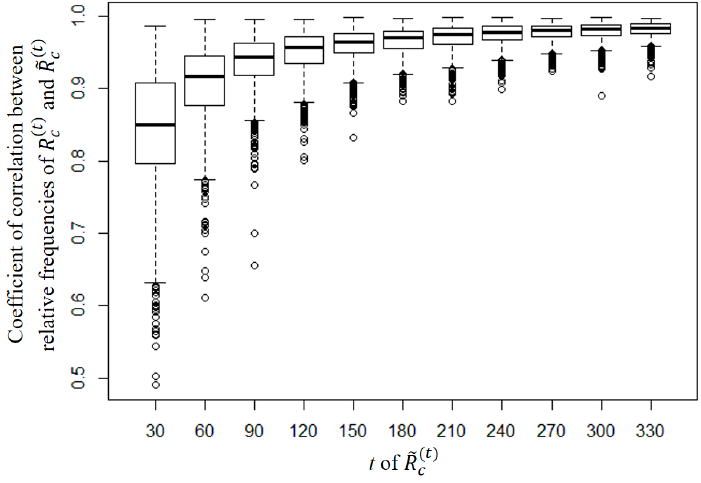
( t ) ( t ) c and (cid:101) R c datasets according to increase in t of (cid:101) R